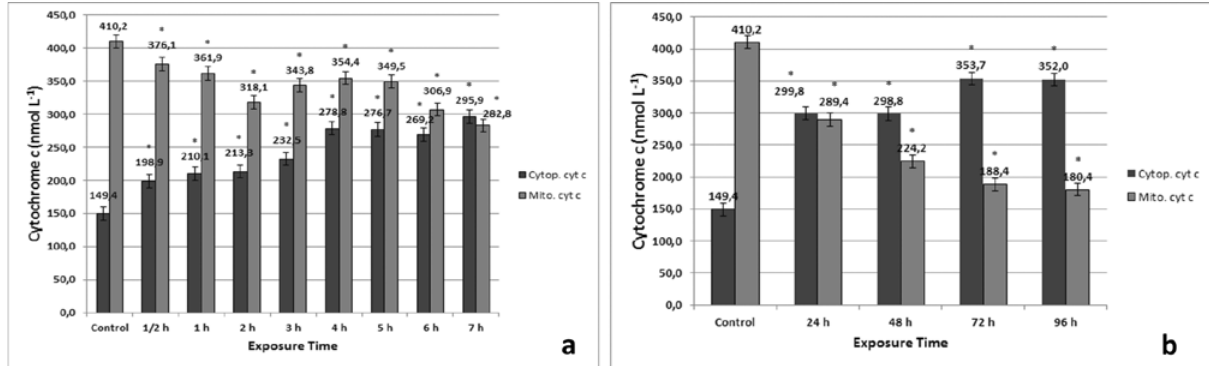
Figure 5. Cytochrome c level in mitochondria and cytoplasm of control and 100 µM AlCl 3 treated barley roots at short (a) and long (b) time points. The data with (*) are significantly different from the control at P < 0.05